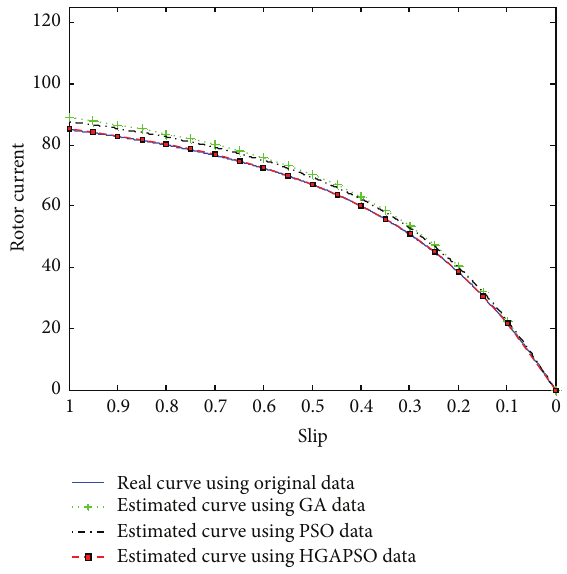
Figure 3: The rotor current versus slip curve using GA, PSO, and HGAPSO data.